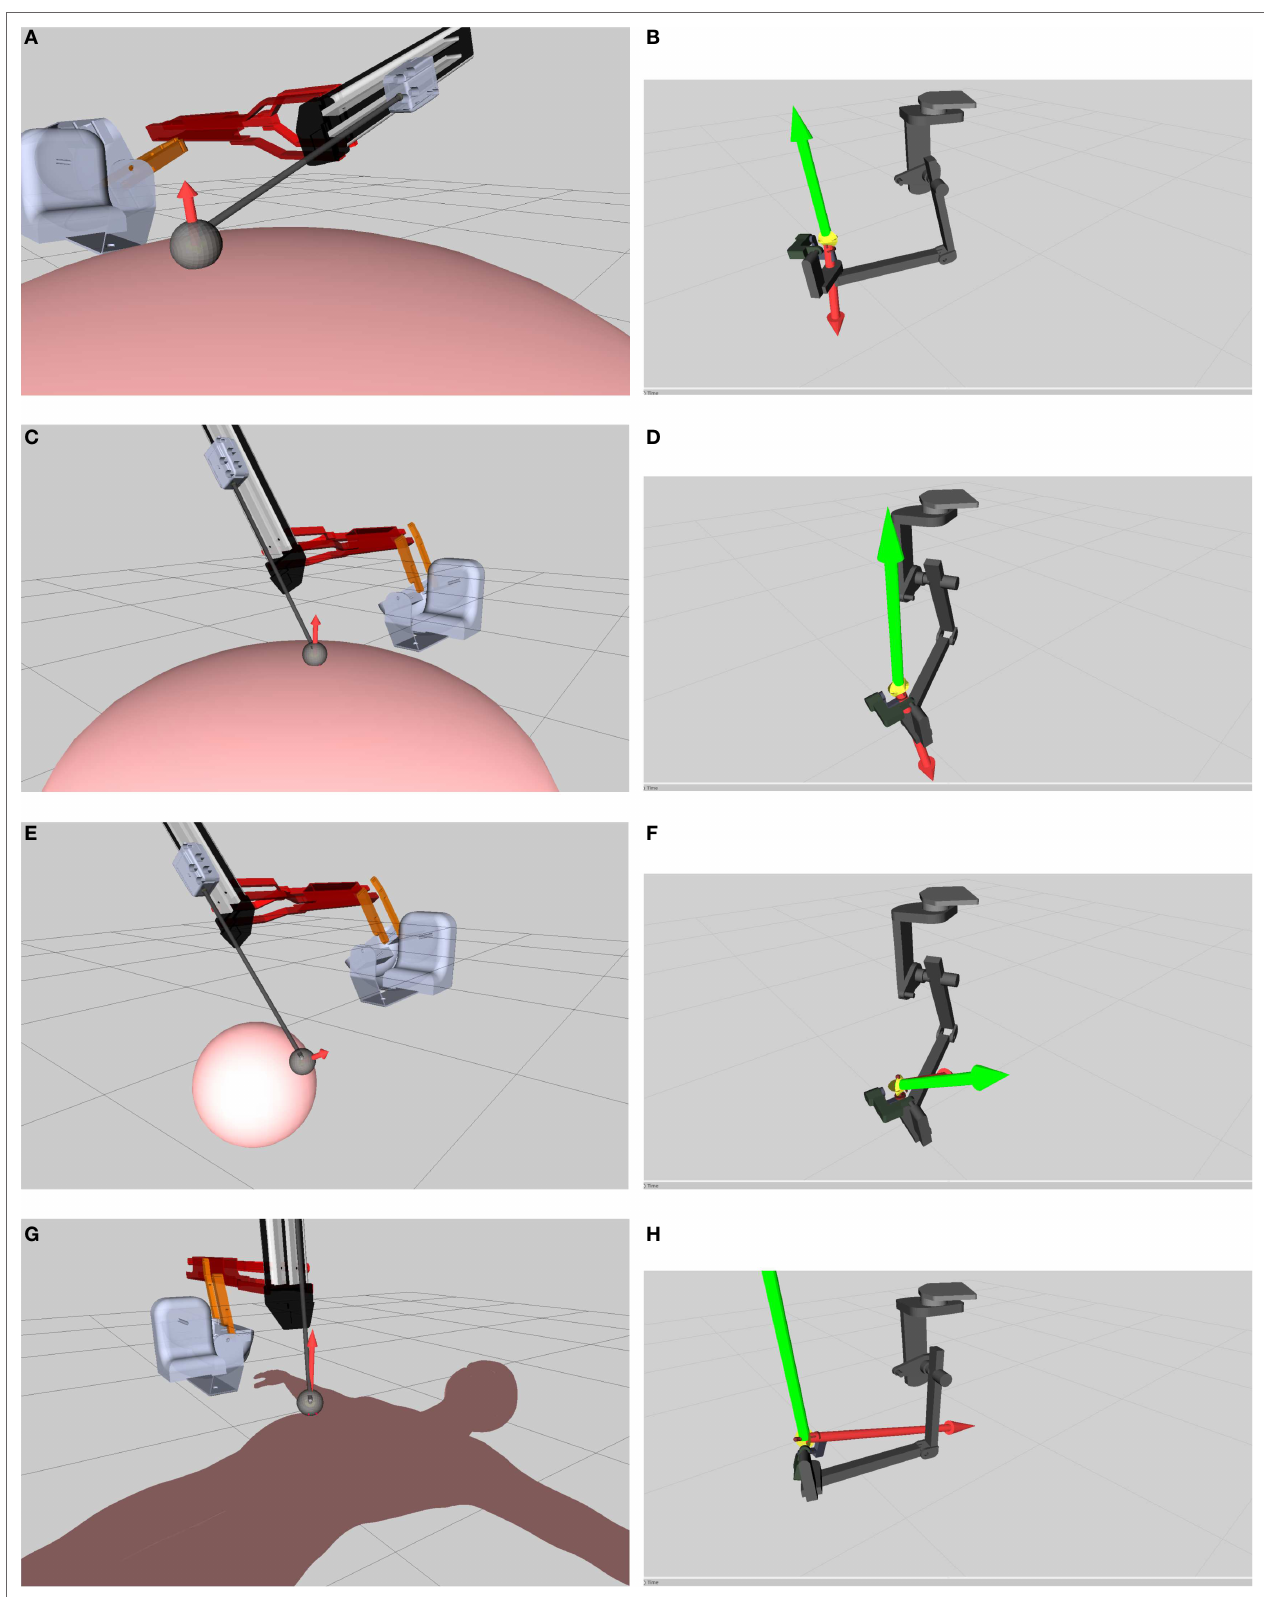
FIGURE 12 | (A,C,E,G) show the PSMs interaction with different mesh environments. (B,D,F,H) show the corresponding haptic feedback at MTMs for each case respectively. The diameter of the SPR is 30mm.